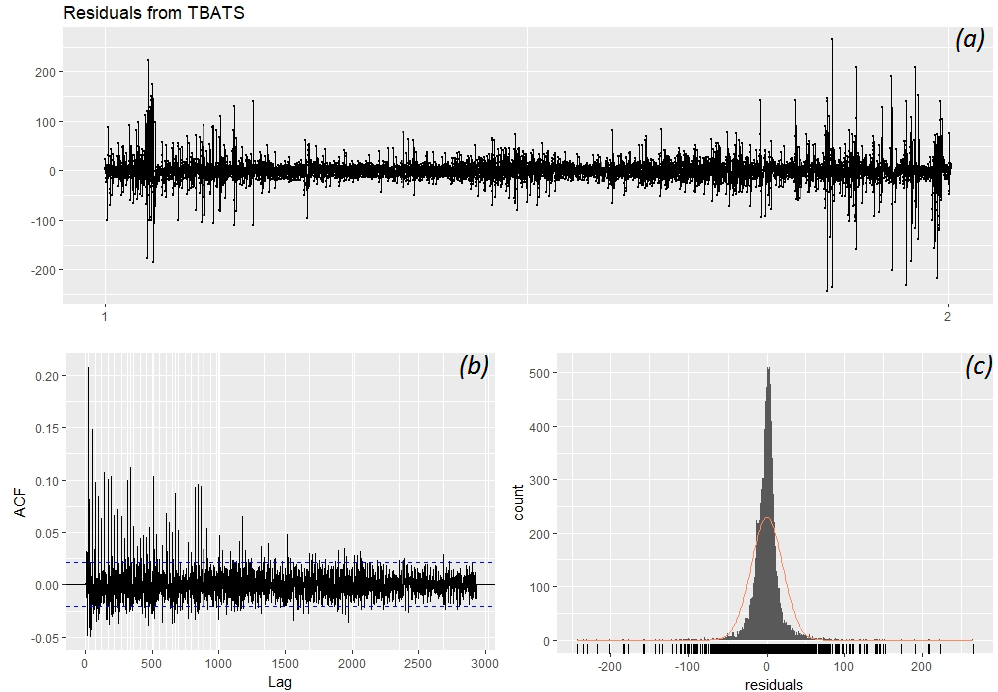
Figure 7. ( a ) Residuals from TBATS; ( b ) The lag operator; ( c ) Count data of residuals.